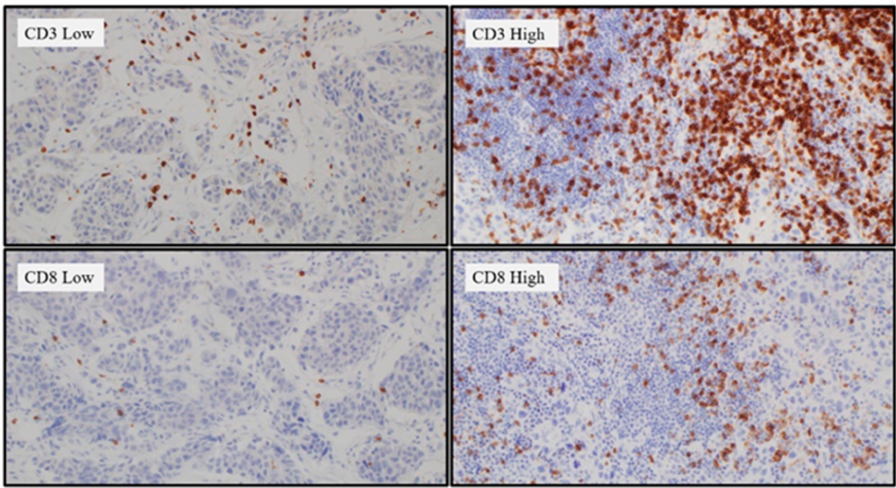
Figure 3. Immunohistochemistry staining of CD3+ and CD8+ T